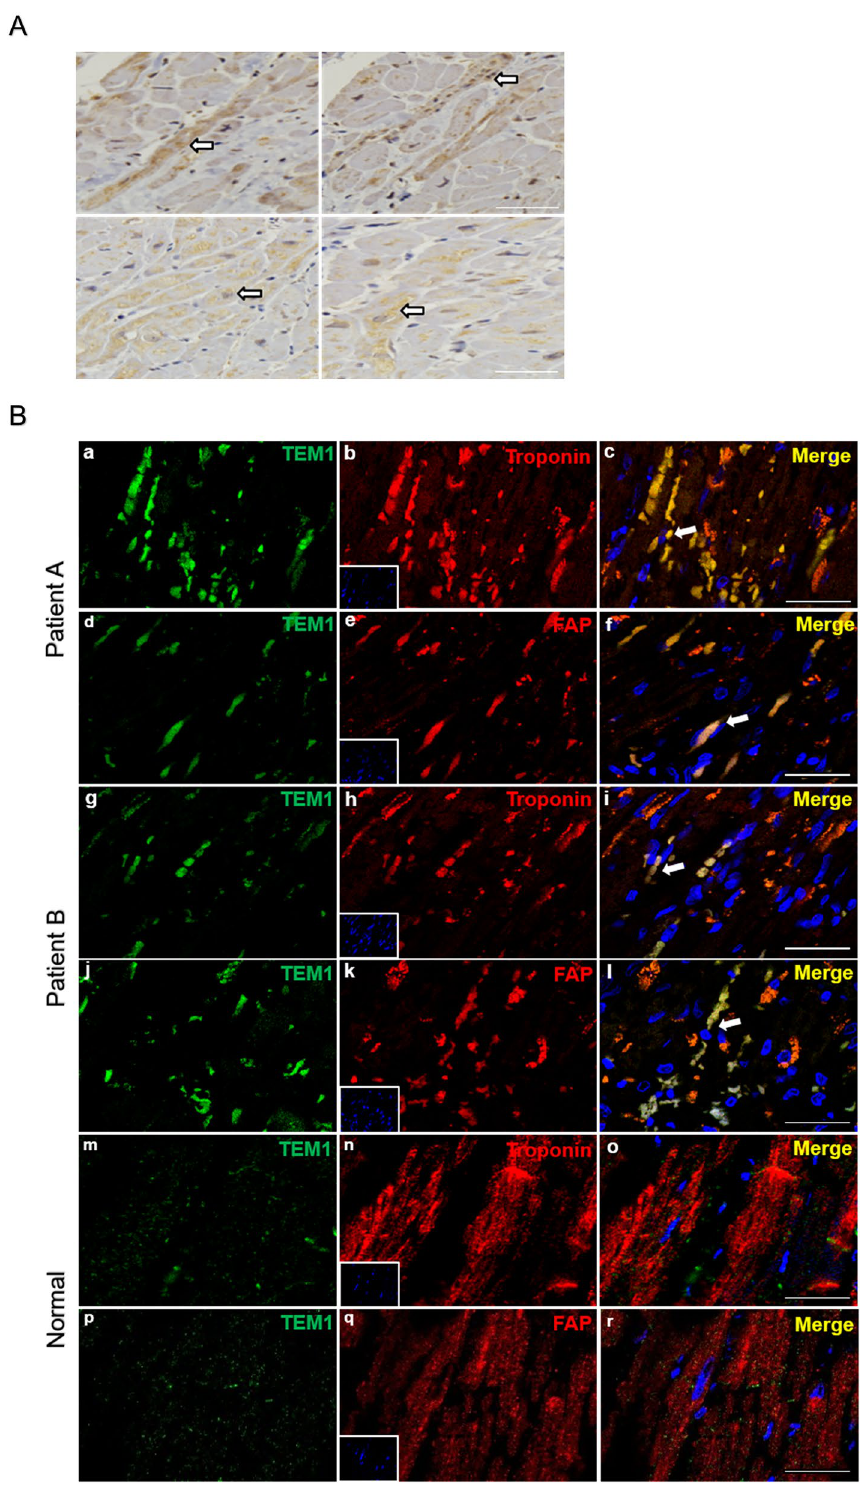
Figure 1. TEM1 in human heart failure. ( A ) Immunohistochemical staining of TEM1 in a cardiac specimen of left ventricle from an explanted heart of patient A received cardiac transplantation. The cell numbers with positive staining in the 4 cross sections were counted and averaged. The ratio of positive staining cells/total cells is 0.62 ± 0.03. Arrows indicate TEM1 staining (brown) in cells. Scale bar = 100 μm. ( B ) Immunofluorescence staining of TEM1 in cardiac specimens of left ventricles from 2 explanted hearts of patient A and B received cardiac transplantation. Representative images show immunostaining for TEM1 (green), troponin (red, cardiomyocyte marker) and fibroblast-activation protein (red, FAP, cardiac fibroblast marker). Nucleus was stained with DAPI (blue). The cell numbers with positive staining in 3 cross sections were counted and averaged in each patient. The ratio of positive staining cells/total cells is: patient A, troponin + TEM1: 0.40 ± 0.02, FAP + TEM1: 0.19 ± 0.02. patient B, troponin + TEM1: 0.34 ± 0.02, FAP + TEM1: 0.29 ± 0.03. Arrows indicate the TEM1 staining (merge) in cells. Scale bar = 25